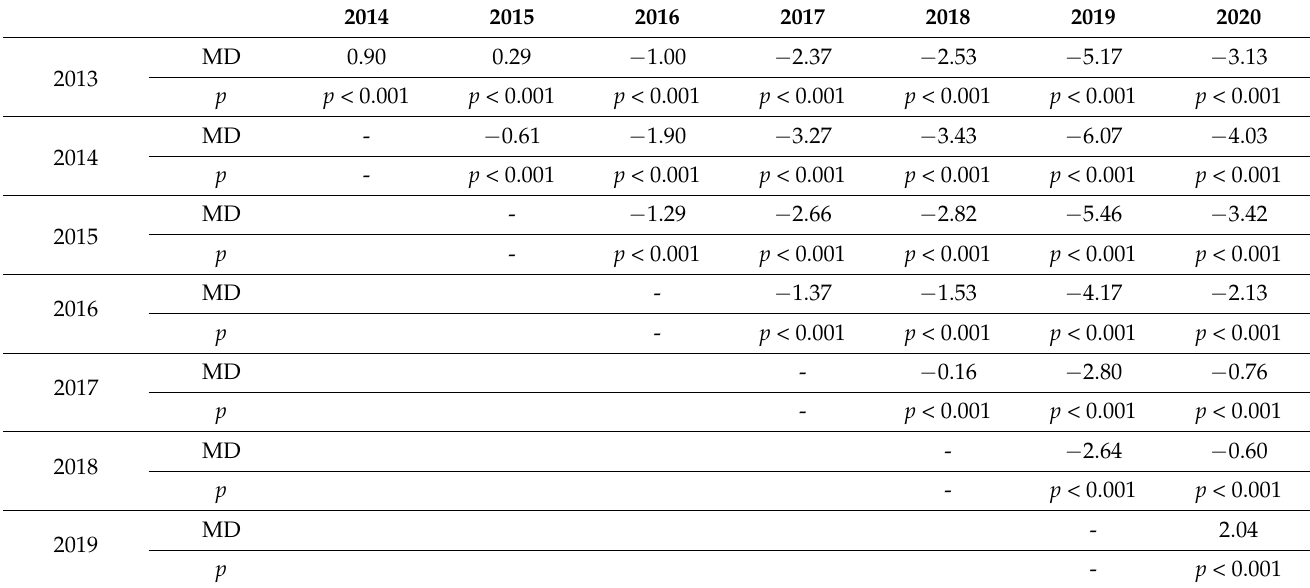
Table 7. Comparison of no delivering defibrillation in the case of PEA and asystole between individual editions of the